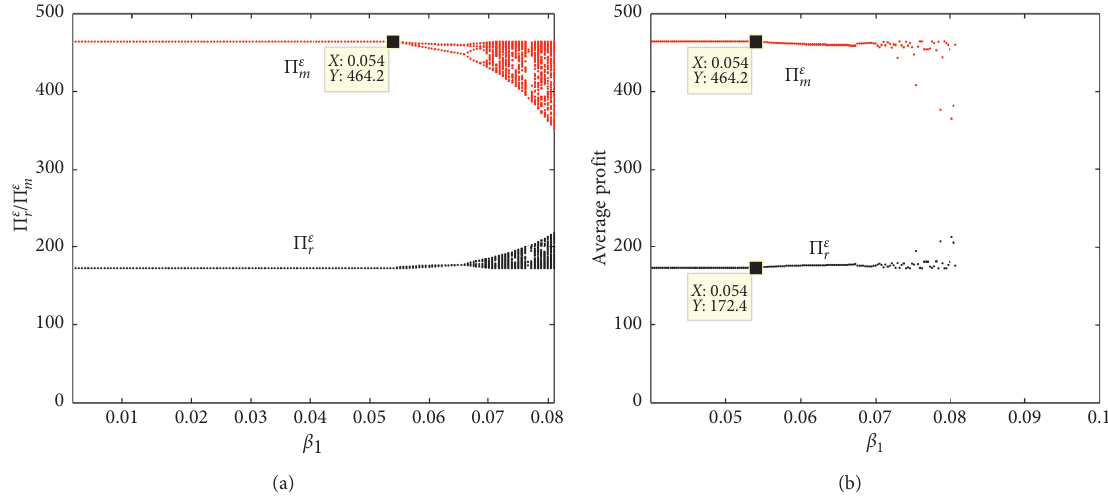
Figure 31: The bifurcation diagram and average profit diagram of 􏽑 diagram. (b) The average profit diagram.